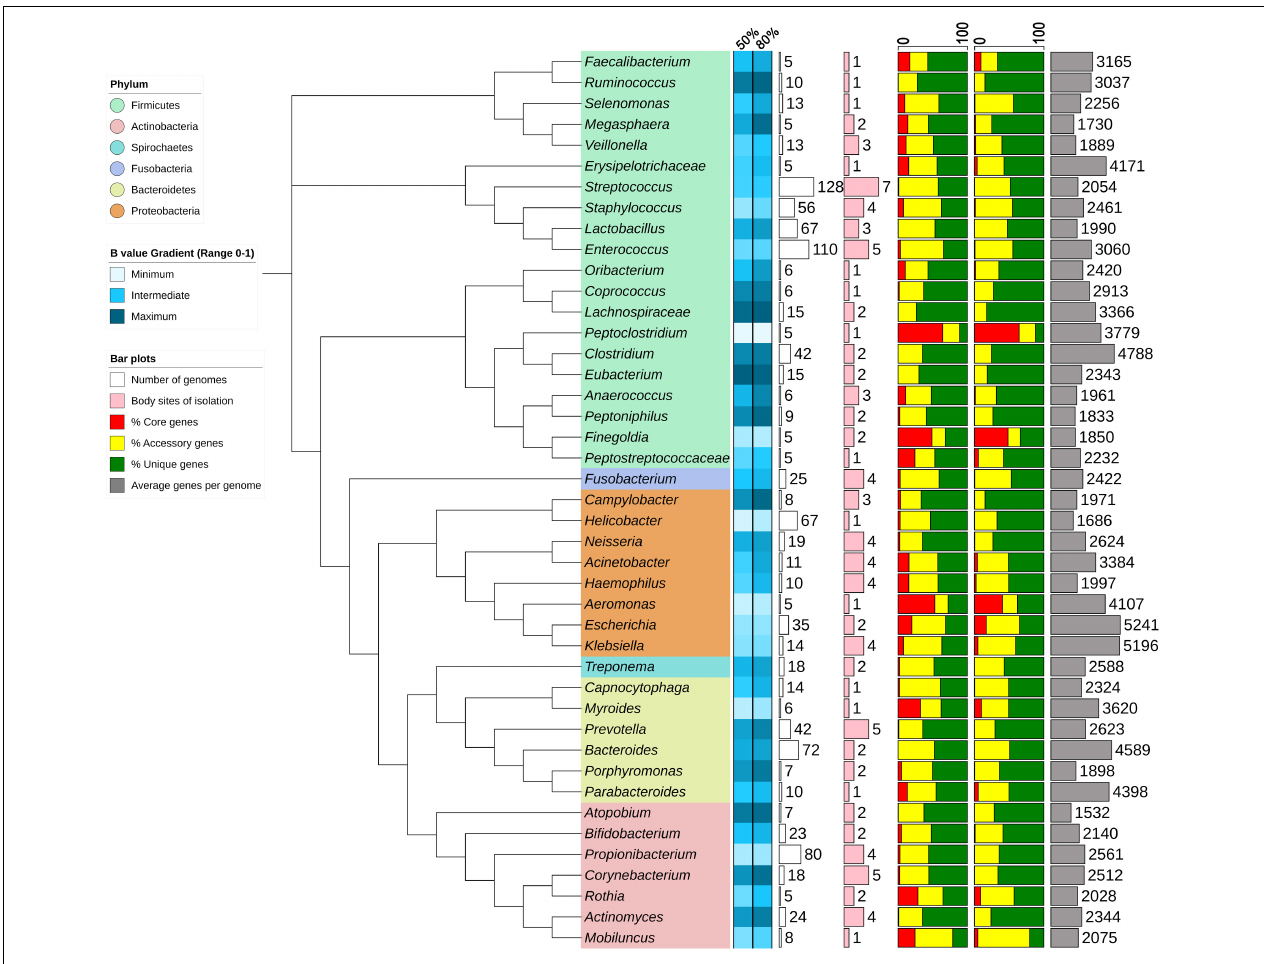
FIGURE 2 | Summary of pan-genome statistics for selected genera. The Neighbor Joining phylogenetic tree is constructed using 16S rRNA genes from representatives of each taxon. The B values are depicted as heatmap and the percentages of core, accessory and unique genes as stacked bar plots for each taxon using 50 and 80% sequence identity cut-offs. The plot and heatmap are constructed by iTOL web server using statistics calculated from